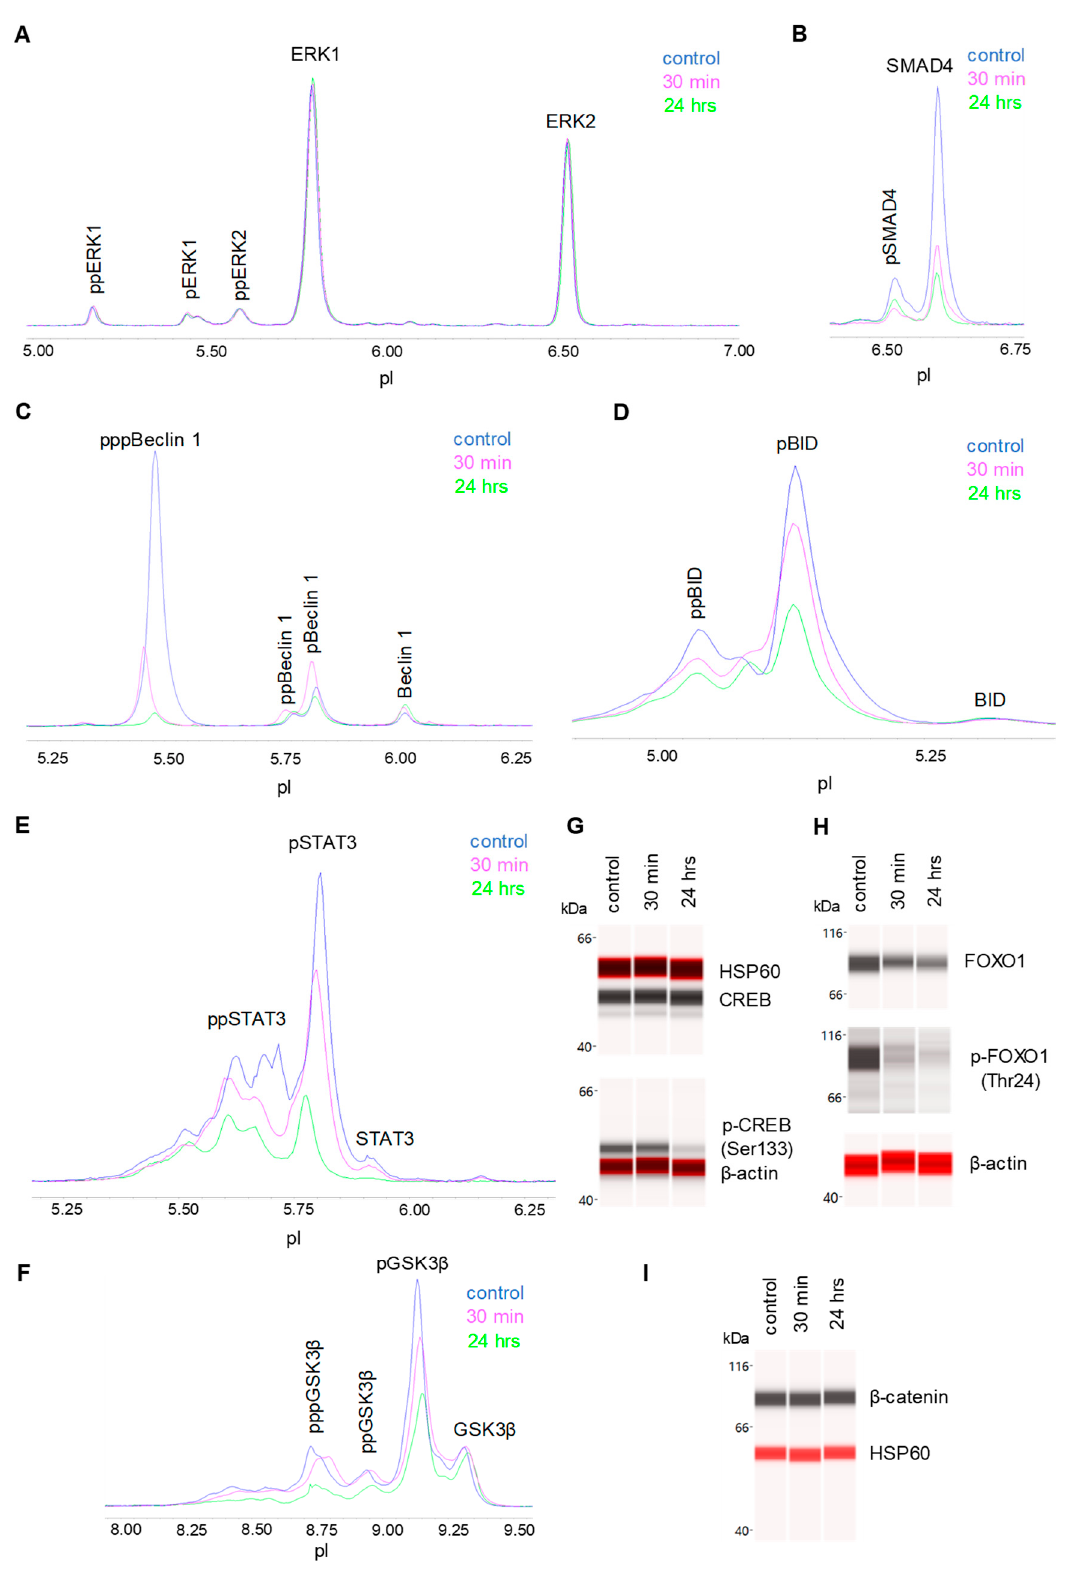
Figure 6. Proteomic profiling of the effects of a CBD oil. The proteomic profiles before and after 30 min and 24 h of treatment with CBD oil V1. ( A ) ERK1/2; ( B ) SMAD4; ( C ) beclin-1; ( D ) BID; ( E ) STAT3; ( F ) GSK3 β ; ( G ) CREB; ( H ) FOXO1; and ( I ) β -catenin. SH-SY5Y cells were treated with CBD oil V1 at 100 µg/mL final CBD concentration.